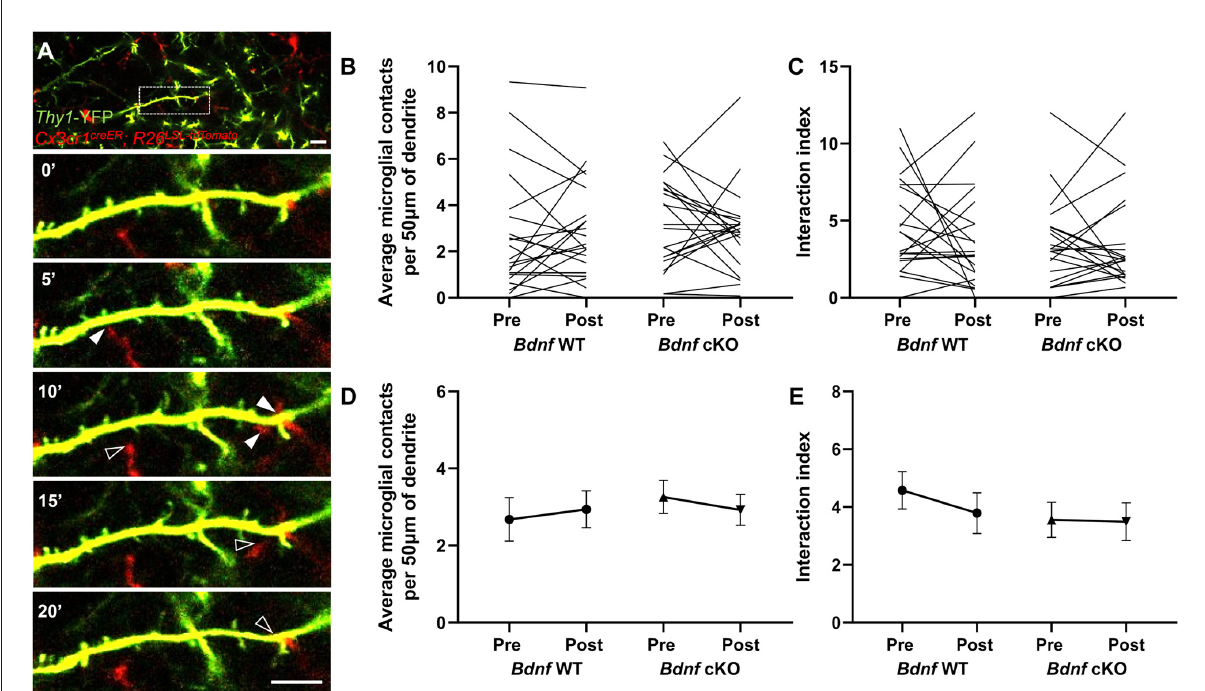
FIGURE3 Deletion of microglial Bdnf does not affect microglia-neuron contacts. (A) Representative time sequence of microglia-dendrite contacts, displaying new contacts (full arrowhead) and contact loss (empty arrowhead). (B,D) Number of microglia-dendrite contacts per timepoint pre- and post-training, plotted (B) per dendrite and (D) as average. Although most dendrites display a shift in the number of contacts after training (B) , there was no difference in the average (D) pre/post training (21 dendrites analyzed from three animals in each group, p = 0.94, two-way ANOVA), or between genotypes ( p = 0.55, two-way ANOVA). (C,E) Calculation of the interaction index (sum of new and lost contacts divided by the number of contacts per timepoint) revealed no difference in the dynamics of microglia-dendrite contacts pre/post (21 dendrites analyzed from three animals in each group, p = 0.68, two-way ANOVA), or between genotypes ( p = 0.52, two-way ANOVA). Scale bar: 10 µ